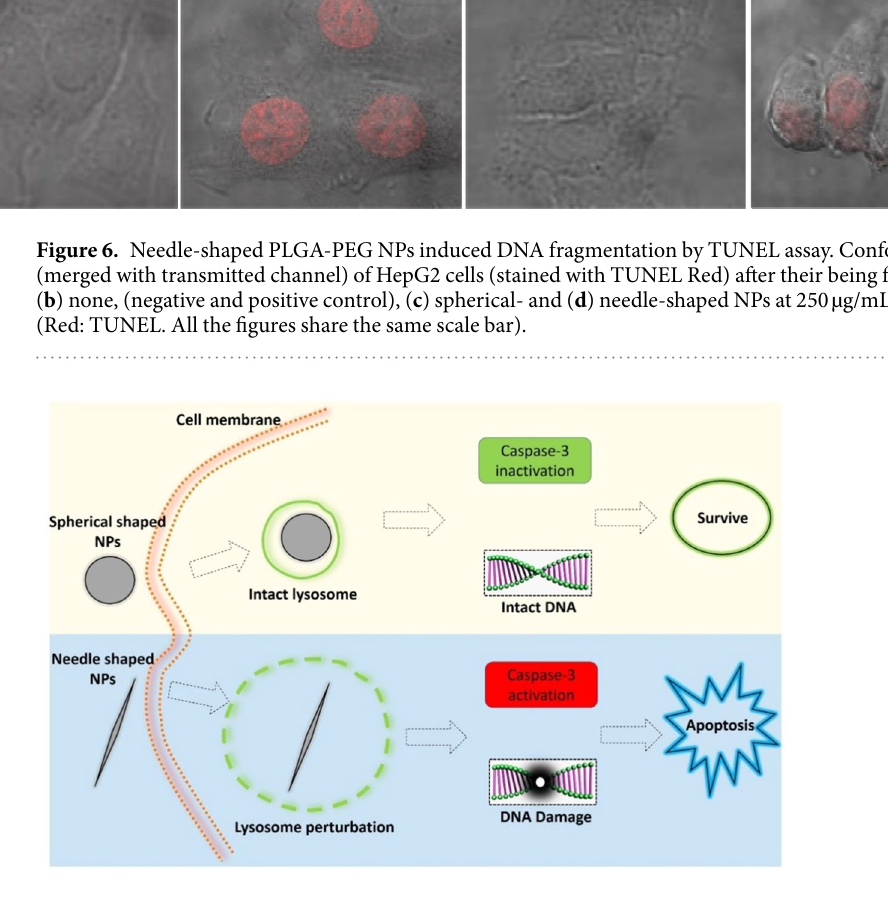
Figure 7. Schematic representation of the proposed cytotoxicity pathways for PLGA-PEG NPs with different morphological features. Upper panel: A spherical-shaped PLGA NP entered the cell via endocytosis, stably resided in the lysosomes, and had no apparent cytotoxicity. Lower panel: A needle-shaped PLGA NP entered the cell via endocytosis, resided in lysosomes and induced lysosomal membrane perturbation, caused caspase-3 activation and DNA damage, and finally